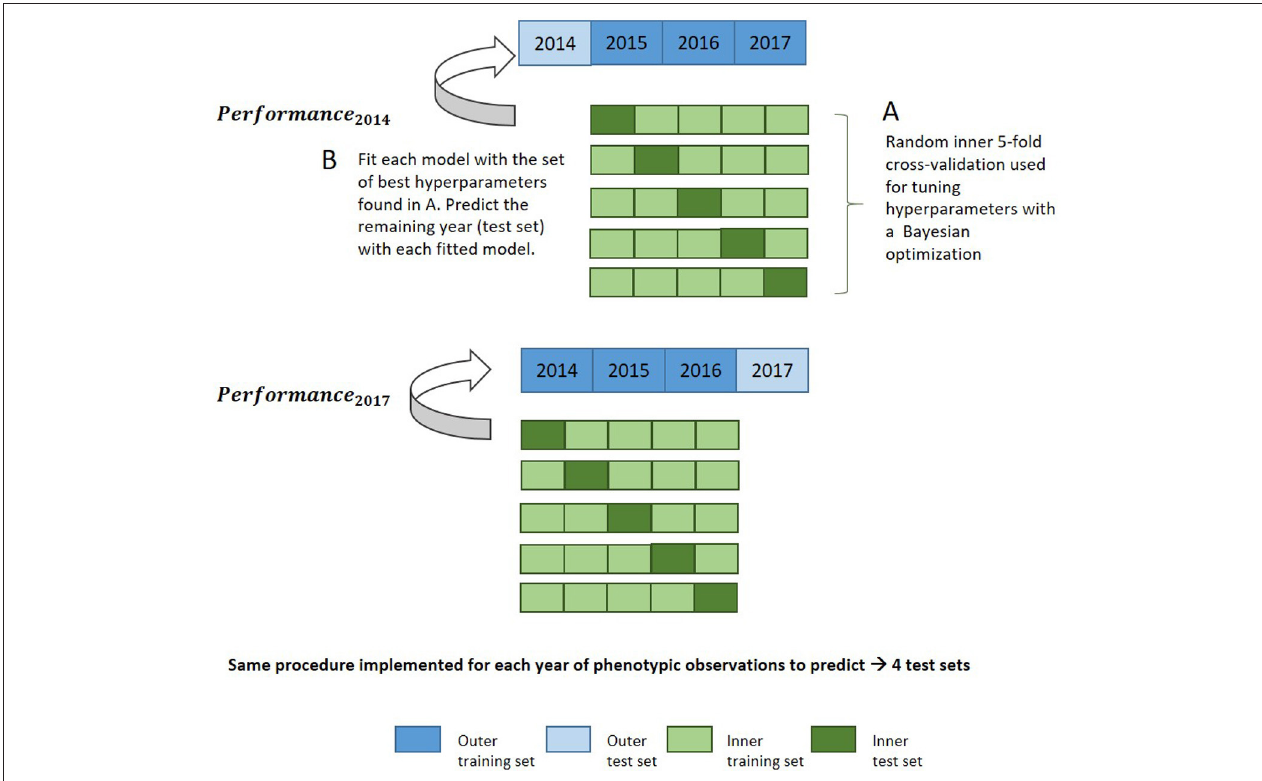
FIGURE 1 | Nested cross-validation diagram for evaluation of model performance in the leave-1-year-out CV scheme with a machine learning